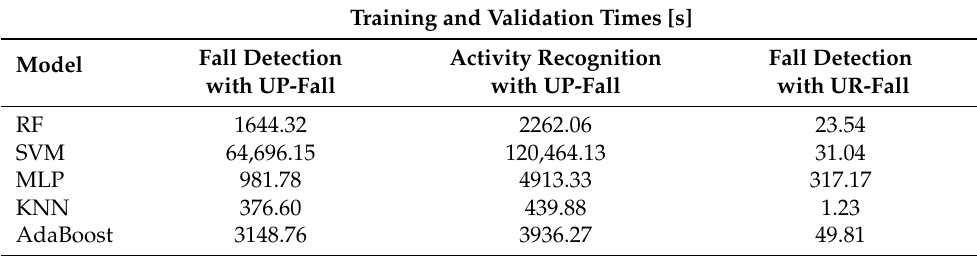
Table 9. Execution times for 10 k-fold of cross validations for each ML